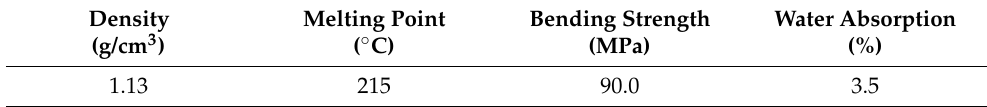
Table 2. The physical properties of the HFRP. Tensile Strength Tensile (GPa)